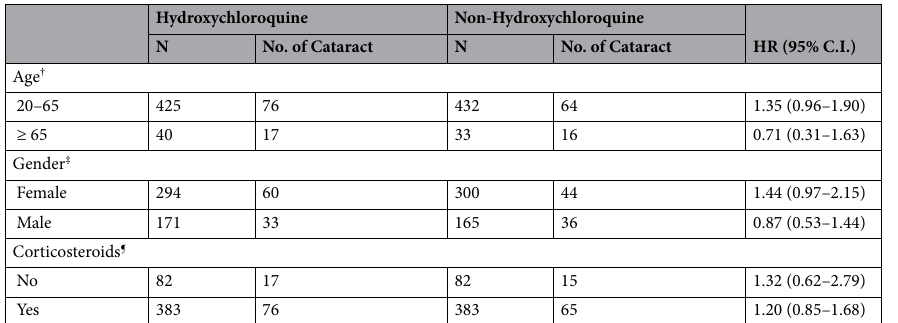
Table 3. Cox proportional hazard model among different Hydroxychloroquine usage duration. † Adjusted for age, gender, hypertension, hyperlipidemia, chronic liver disease, chronic kidney disease, COPD, diabetes, uveitis, methotrexate, biologics, ophthalmology, and corticosteroids.